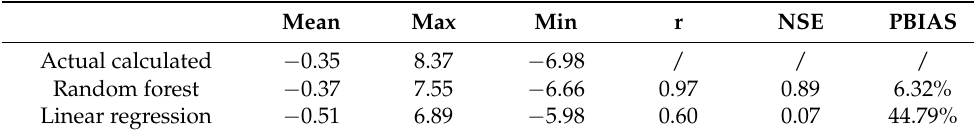
Figure 11. Comparison of scPDSI between reconstructed results based on RF and LR (3725 grid points, 0.5° × 0.5° resolution) and actual calculated value (3725 grid points, 0.5° × 0.5° resolution). ( a ) Variation of annual average; and ( b ) density curve of different scPDSI categories. Table 4. Several types of statistical factors of RF and